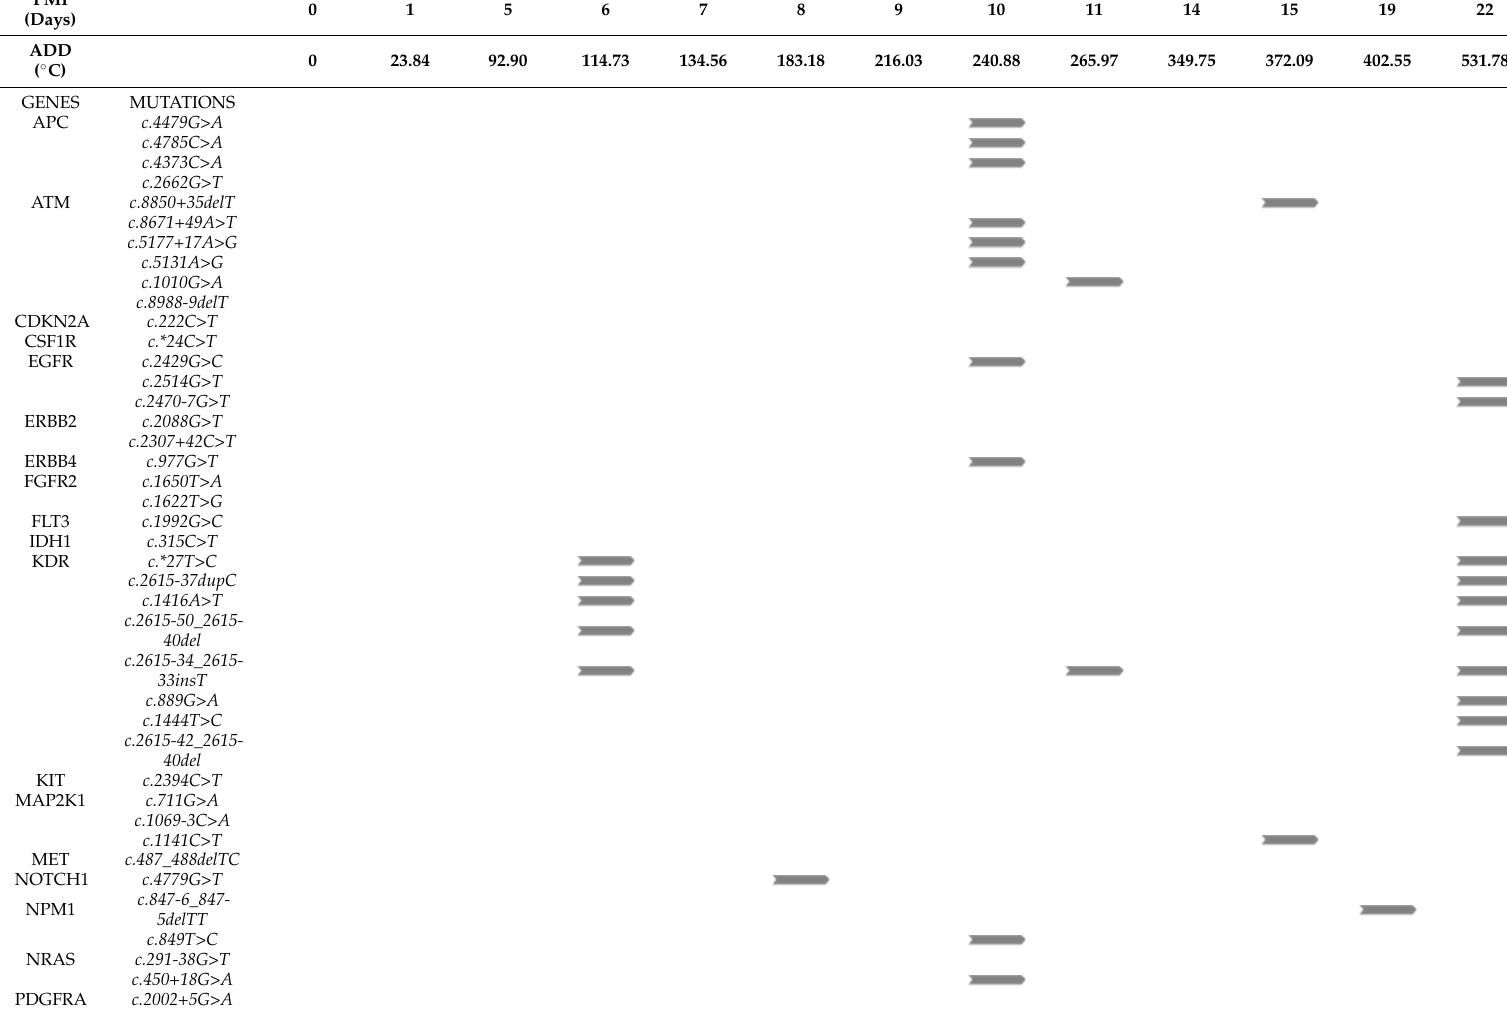
Table 3. Mutations that were found only during specific PMIs.